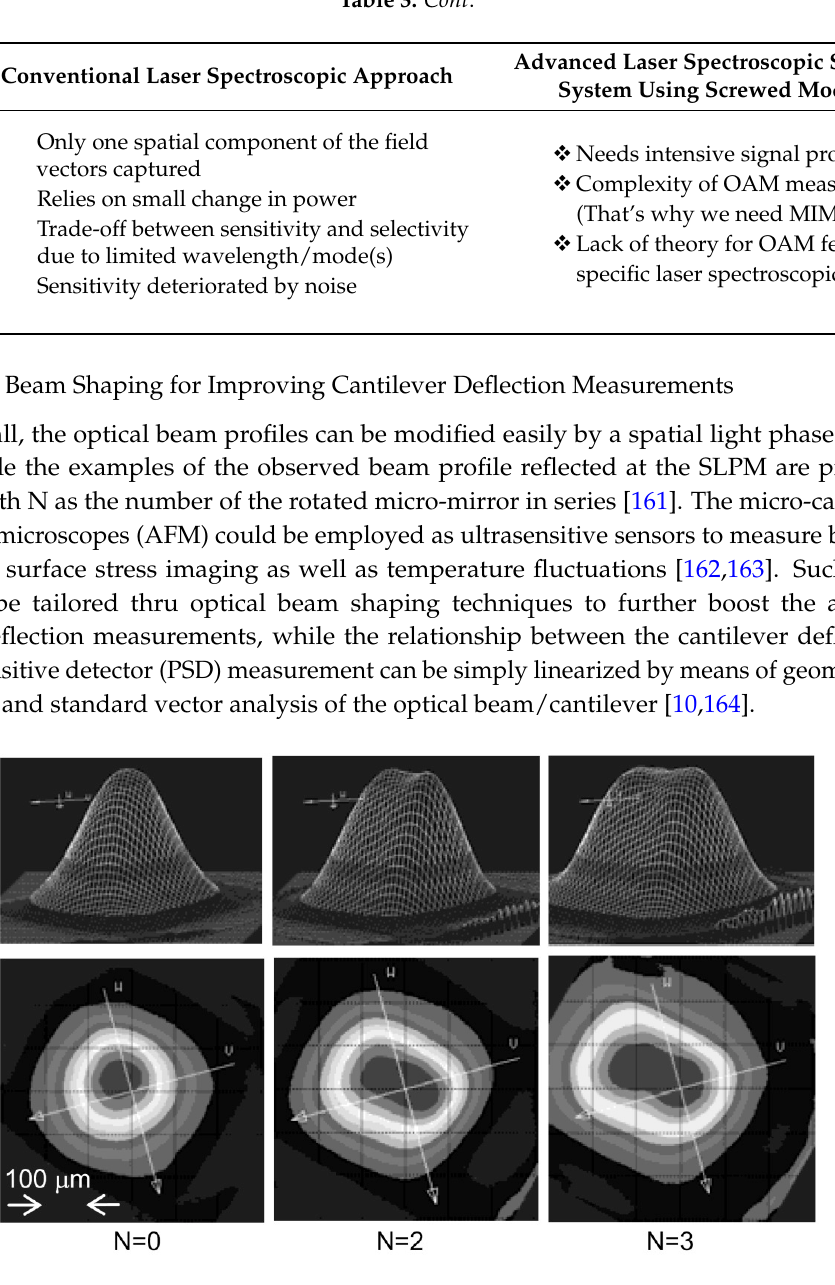
Figure 21. Examples of the observed beam profile reflected at a spatial light phase modulator (SLPM) [161].